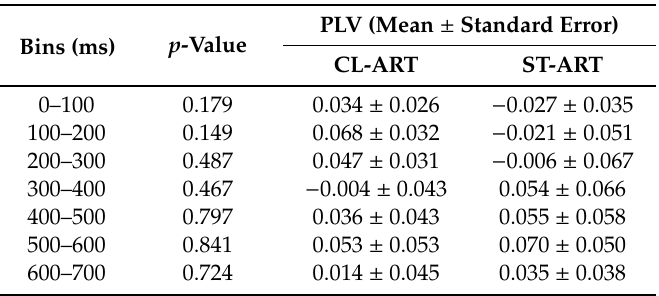
Table 4. Summary of one-way ANOVA analysis results for IEC( θ ) di ff